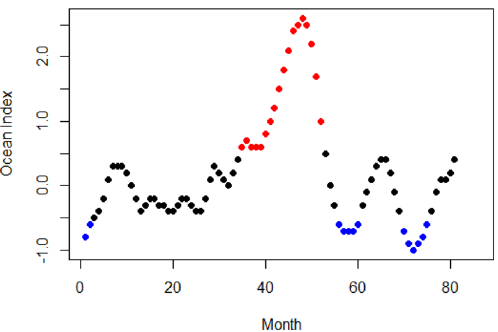
Figure 1. Three month running means of ENSO Oceanic indices (ENSO OI) from February 2012 until October 2018. Points with a strong negative score (< − 0.5) are colored blue while points with a strong positive score (> 0.5) are colored red.